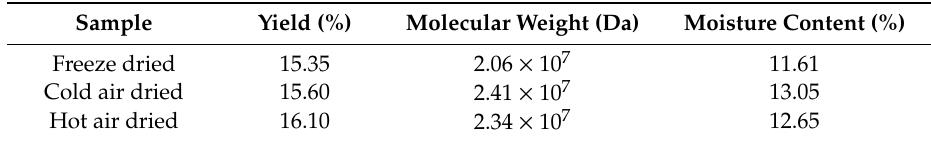
Table 2. Yield, molecular weight, and moisture content of T. fuciformis polysaccharides obtained by various drying processes.